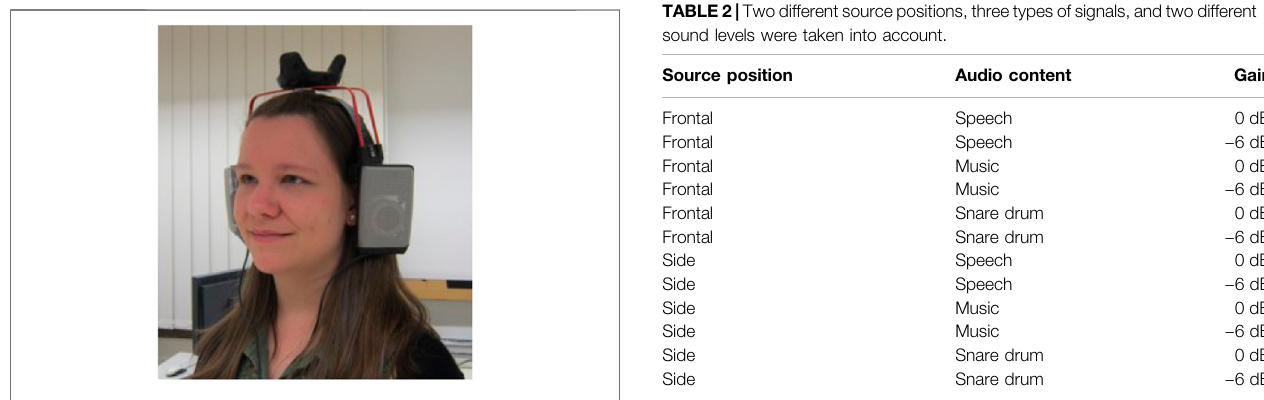
FIGURE 3 | Test person wearing AKG K1000 headphones with a Vive tracker attached to them.